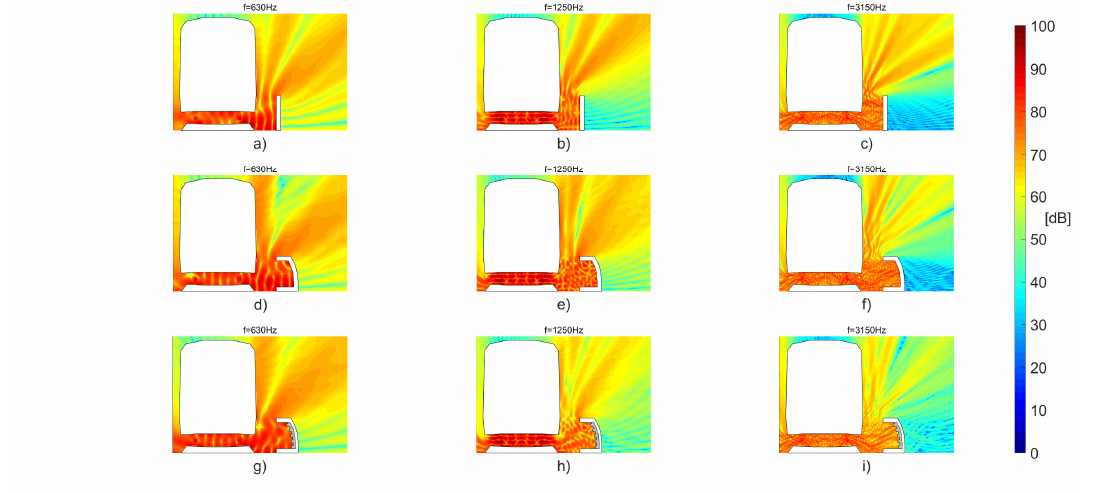
Figure 19. Comparison of the SPL for the vertical barrier ( a – c ), for the curved barrier ( d – f ) and for the curved barrier with porous material ( g – i ) IL colour maps are plotted for the centre frequencies of the one-third octave bands (315–4000 Hz) in Figures 20 and 21 for the curved barrier scenario with porous